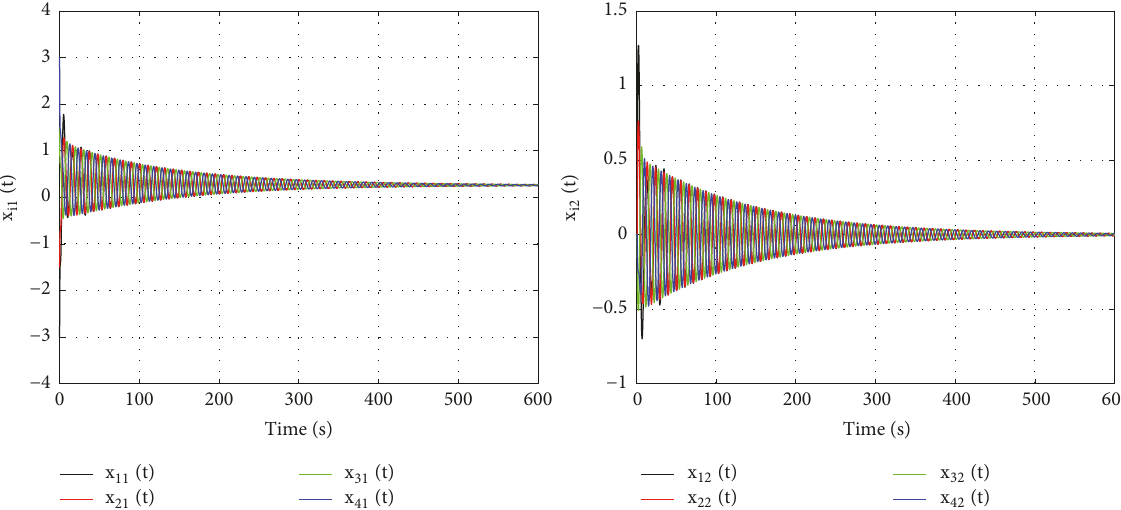
Figure 9: The trajectories of all agents’ states in the FOMAS with double integral and asymmetric time-delays when all 𝜏 𝑚 < 𝜏 in Example 4.